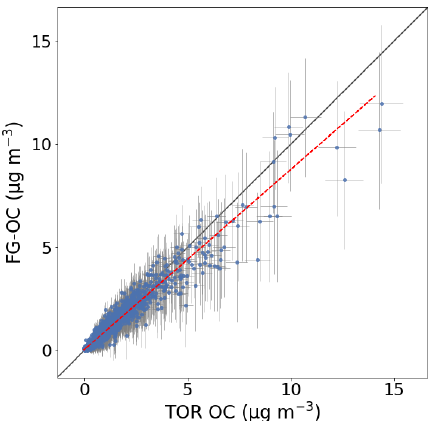
Figure 7. Mean OM and OM / OC for each cluster. Colors indicate FG contributions to the OM /